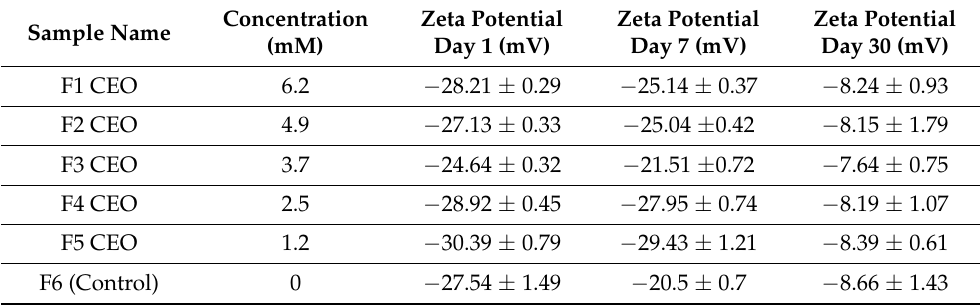
Table 3. Zeta potential values of CEO nanoliposomes (F1 to F5 fractions) and control sample (F6 fraction) after day 1, 7, and 30 of storage at 4 ◦ C. Data were articulated as mean values ± standard